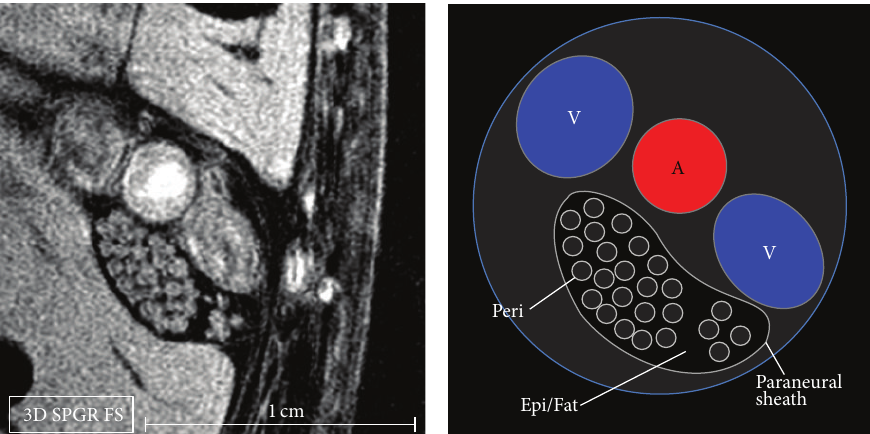
Figure 3: 3D SPGR FS. Axial section of the neurovascular bundle at the ankle with the tibial nerve and the corresponding schematic diagram. In-plane resolution is ∼ 100 𝜇 m. The paraneural sheath is hyperintense. The epineurium and the epineurial fat (Epi/Fat) appear hypointense because the fat is suppressed and the epineurium has a fibrous structure with low signal. The perineurium (Peri) is hyperintense. The artery (A) demonstrates a thicker wall compared with the paired veins (V). The neurovascular bundle is surrounded by a fatty, supporting tissue and enclosed within a thicker connective fascia.